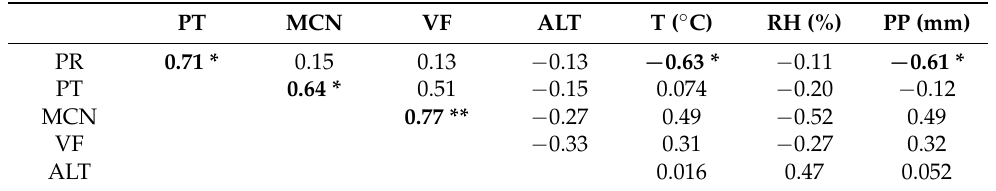
Table 2. Pearson correlation analysis between the variables: total registered diseases (PR); esti- mated total population (PT); frequency of micronuclei (MCN); vehicular flow (VF); altitude (ALT); temperature (T ◦ C); relative humidity (RH%); and rainfall (PP mm). PT MCN VF ALT RH (%)